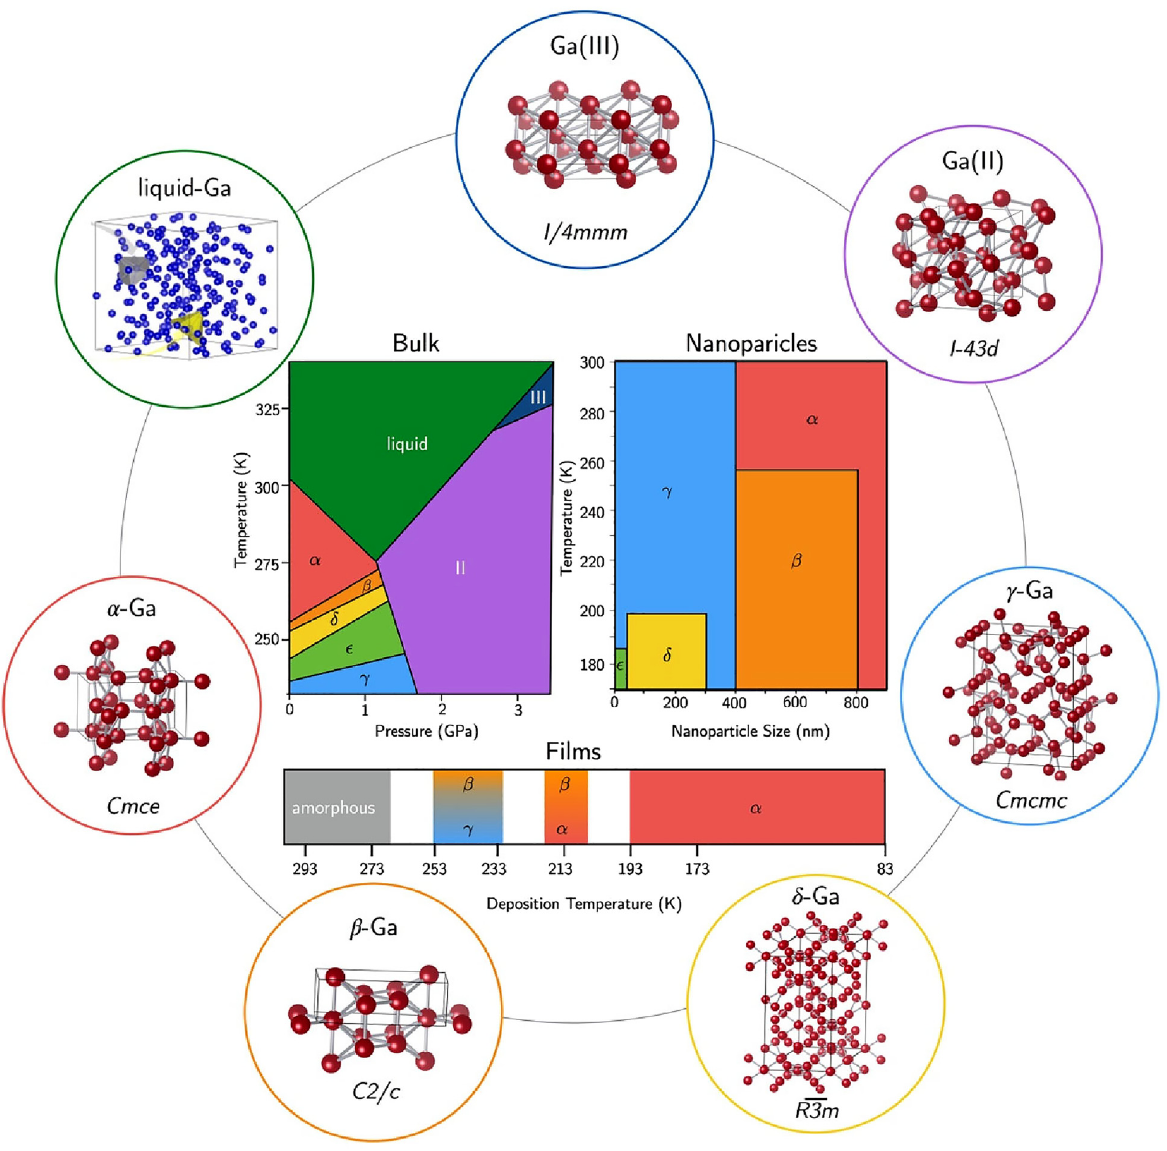
Figure 1: Phase diagram of bulk gallium (Ga) [26] (left) and of Ga nanoparticles [11] (right) as a function of nanoparticle size and scheme of various Ga phases thin fi lms that can be obtained as a function of the deposition temperature [27] (bottom), reconstructed from several referenced sources. The schemes of the different unit cells of each of the crystalline phases are also indicated [26, 28 –